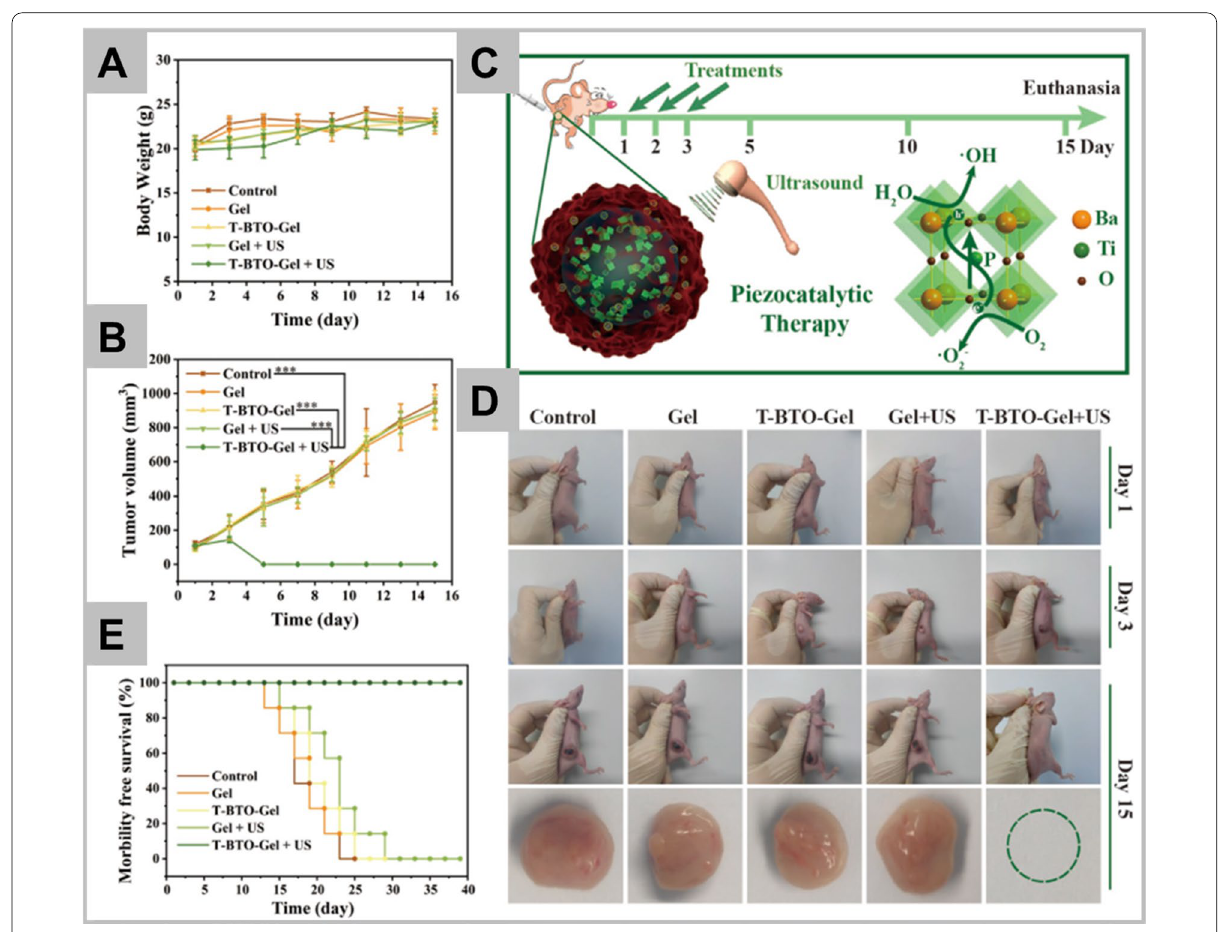
Fig. 7 In vivo piezocatalytic therapy on tumor regression under US irradiation. Time-dependent body-weight curves (Panel A ), and time-dependent tumor-growth curves of tumor-bearing mice after different treatments, including control group, Gel group, T-BTO-Gel group, Gel US group, and T-BTO-Gel US groups (*p < 0.05, **p < 0.01, ***p < 0.001) (Panel B ). Schematic illustration of piezocatalytic therapy in vivo + + (Panel C ). Digital photos of 4T1-tumor- bearing mice and their tumor regions after various treatments at different intervals (Panel D ). Survival curves of tumor-bearing mice after treatment (Panel E ). Reprinted with permission from Advanced Materials, Copyright 2020, John Wiley and Sons